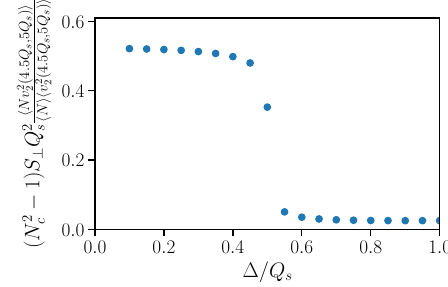
Fig. 2 Leftpanel: the three particlecorrelationfunction (cid:4) v 2 by the normalized correlations between v 2 produced particles. The calculation of v 2